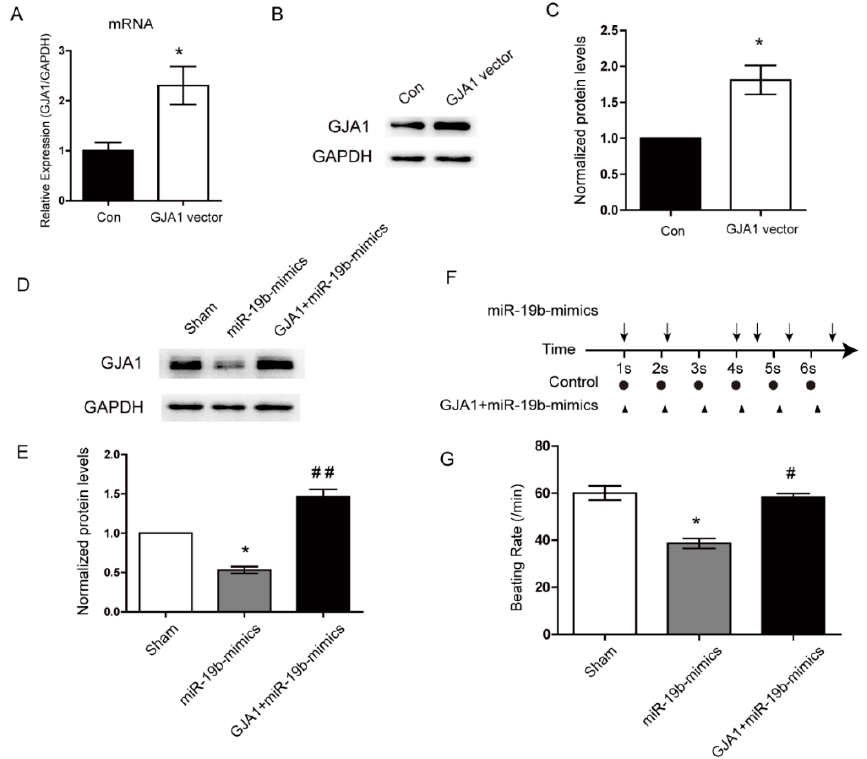
Figure 4. Overexpression of miR-19b led to irregular beating by decreasing the GJA1. ( A ) The transfection efficiency of GJA1 expression plasmid was assessed in hiPSCs-CMs by qPCR; ( B , C ) Western blot assay detected the transfection efficiency of GJA1 expression vector; ( D , E ) Western blot assay revealed that miR-19b mimics could significantly decrease the GJA1 protein level in hiPSC-CMs, while the GJA1 vector could restore the above effect; ( F ) The beating patterns of cardiomyocytes in different groups. Arrows represented the hiPSCs-CMs which were transfected with miR-19b mimics. The triangle represented the hiPSCs-CMs which were transfected with the GJA1 vector and miR-19b mimics; ( G ) The beating rate of hiPSCs-CMs was shown in different groups. The enhanced GJA1could rescue the beating rate. n = 3 per group. * p < 0.05 vs . control. # p < 0.05, ## p < 0.01 vs. the group of miR-19b mimics.